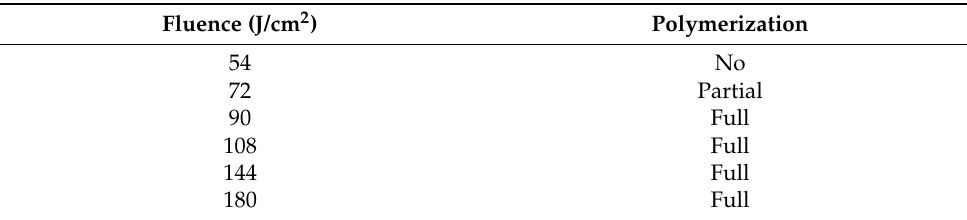
Table 1. TiO 2 –SiO 2 photosensitivity between 54 and 180 J/cm 2 through amplitude mask method.